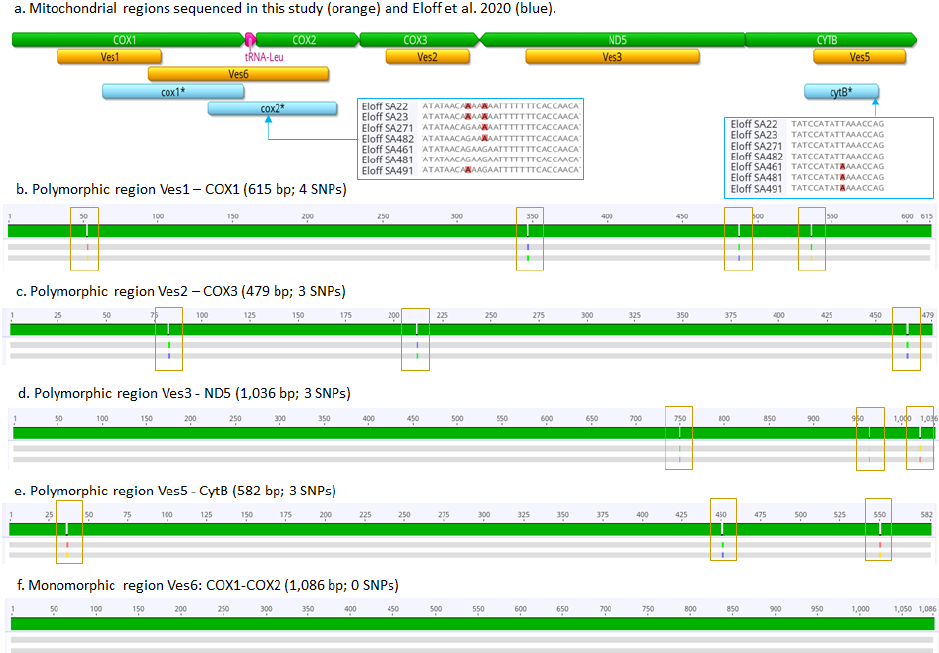
Figure 2. ( a ) Mitochondrial regions sequenced in this study and in Eloff et al. 2020 [9]. Blue boxes show the position of SNPs in COX2 and CytB reported in [9] but not found in this study. ( b – e ) Orange boxes highlight SNPs in the sequenced polymorphic regions. ( f ) Ves6 was monomorphic in this study, but Eloff et al. [9] reported SNPs therein. cox1*, cox2* and cytB*-regions sequenced in Eloff et al. [9].